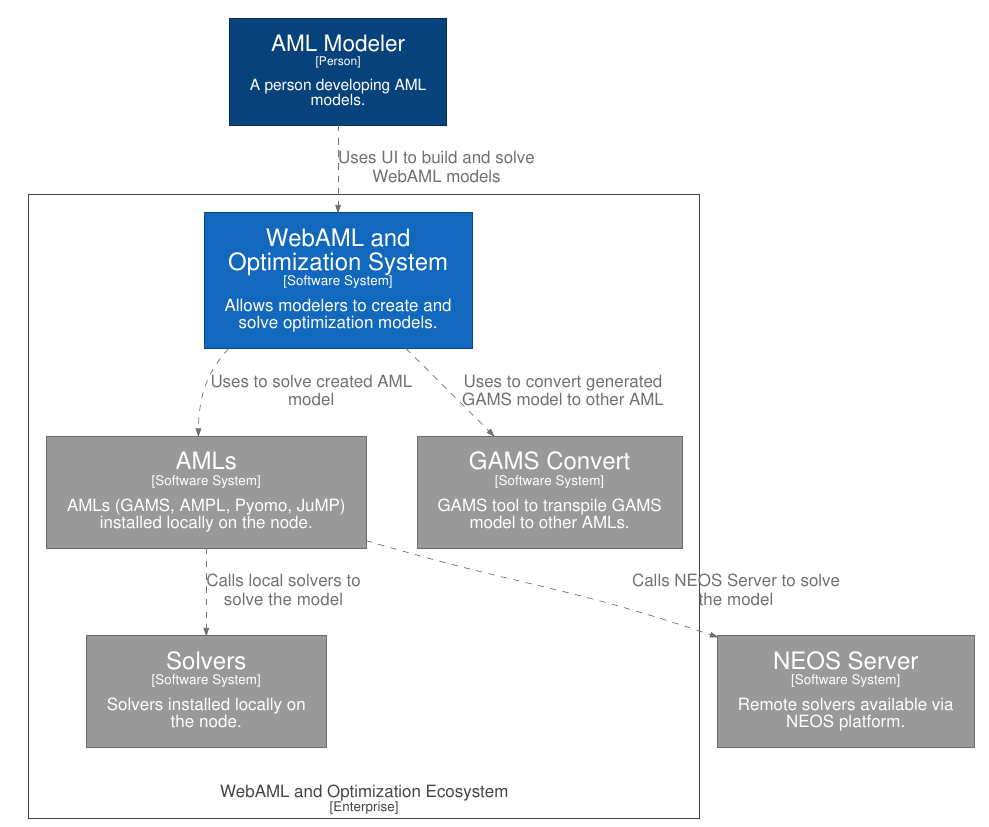
Figure 2. C4 architectural model of a system landscape for the prototype of WebAML Optimization System. Gray boxes indicate external elements provided by other